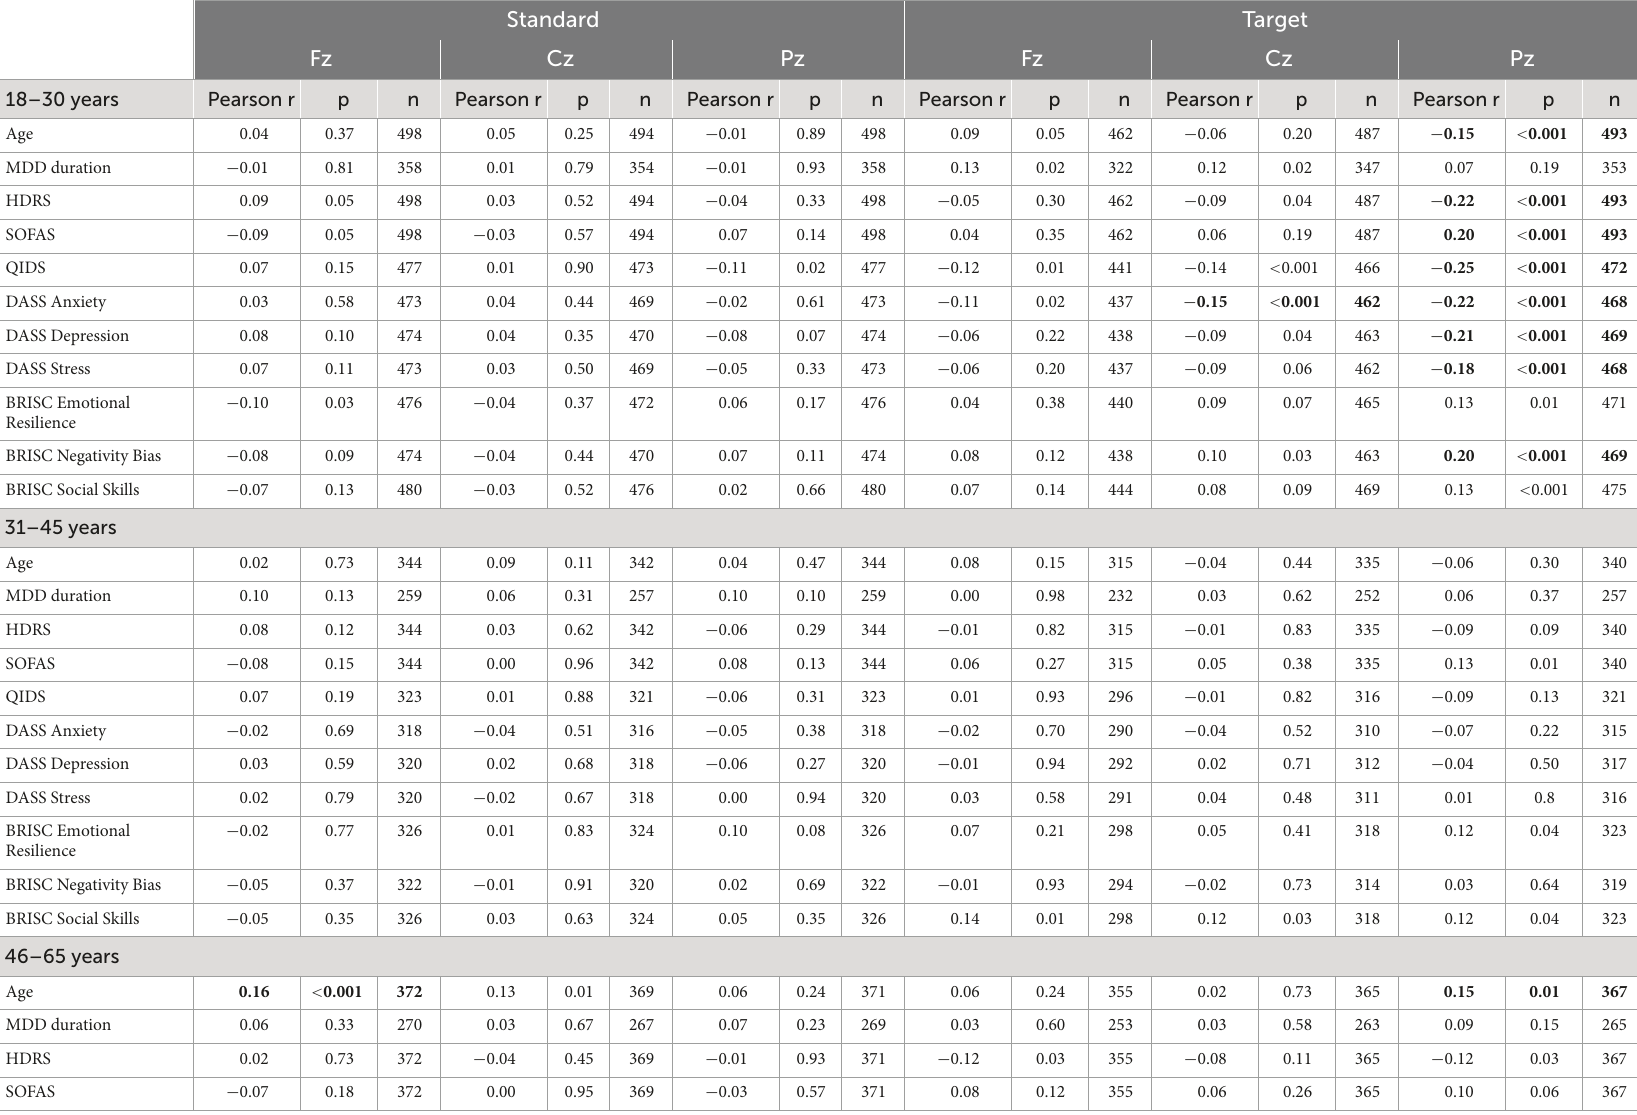
TABLE 3 Correlations between the P300 amplitude at the Fz, Cz, and Pz locations in response to standard and target sounds and behavioral